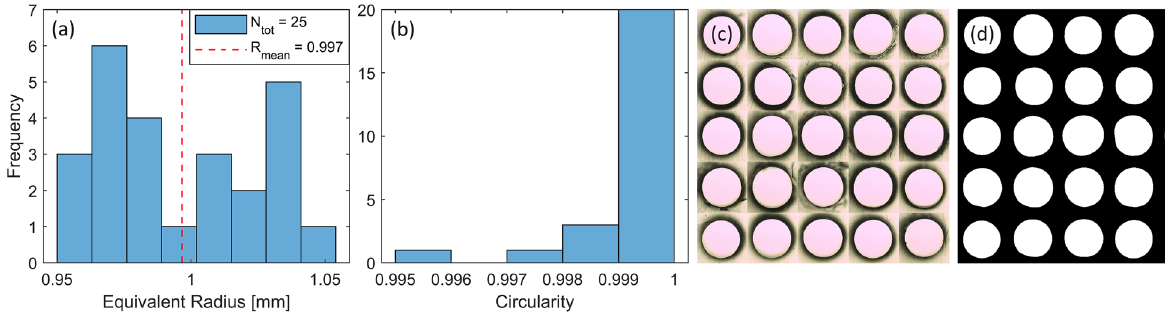
Figure 3. We examine the circular test channels with a design radius of 1 mm using a microscope and analyze them for size and shape in MATLAB [R2021a, The MathWorks Inc.]. This was done by 3D printing, molding and dissolving 25 individual channels, cutting a cross-section from each, and photographing them. Panel ( a ) shows the distribution of equivalent radius and this is calculated as the radius of a circle with the same area as the channels cross-section. In panel ( b ), we show an estimate of the channels circularity. It is calculated as ( 4 π Area )/ Perimeter 2 , and approach unity for a perfect disk. In panels ( c ) and ( d ), a montage of all the cross sections are shown before and after image filtering, respectively.